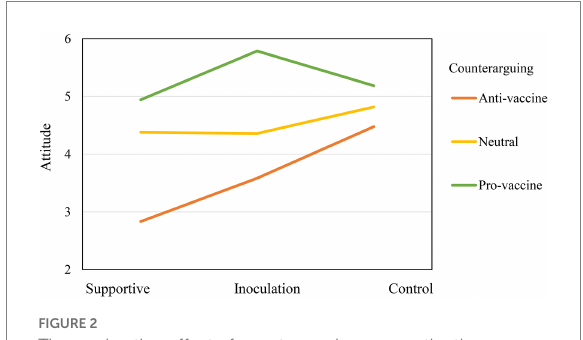
FIGURE 2 The moderating effect of counterarguing among the three